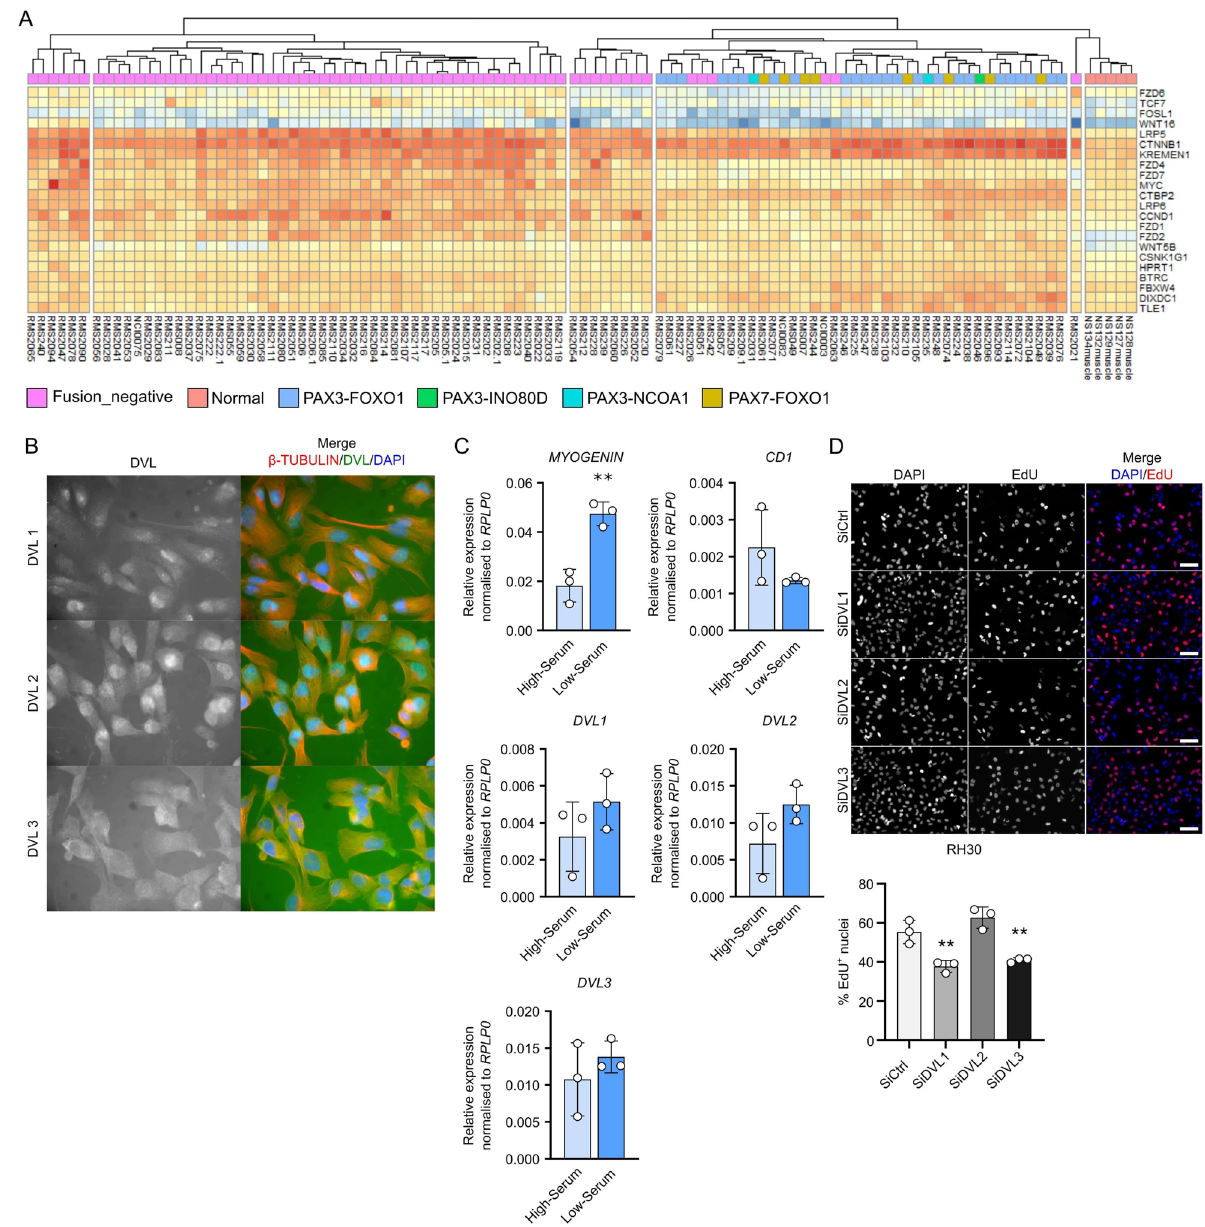
Figure 8. Knockdown of DVL1 or DVL3 reduces proliferation in alveolar rhabdomyosarcoma cells. ( A ) Heatmap of 22 differentially expressed genes associated with the WNT pathway in fusion-negative (pink) and fusion-positive (various colours) rhabdomyosarcoma biopsies and healthy muscle controls (Normal – orange) (GSE108022). ( B ) Localisation of DVL1-3 (green) in RH30 ARMS cells exposed to high-serum medium, co-immunolabelled for β-TUBULIN (red) with nuclei counterstained with DAPI (blue). ( C ) Gene expression profiles for DVL1-3 , the proliferation marker CD1 and the early differentiation marker MYOGENIN in RH30 cells exposed to high or low-serum medium. N = 3 independent biological replicates. Significant differences were assessed using a students unpaired two tailed T-test, comparing high-serum to low-serum culture conditions where two asterisks denote p < 0.01. (D) Representative images of proliferating RH30 cells that have incorporated EdU (red) after individual knockdown of each DVL isoform for 48 h, with nuclei counterstained with DAPI (blue). Scale bar represents 100 µm. Quantification of EdU containing cells as a percentage of total nuclei after knockdown of each DVL isoform. Statistically significant differences were calculated using a One-Way ANOVA with Dunett’s post-hoc test, comparing each group with the control (SiCtrl). A significant difference is denoted via two asterisks where p < 0.01. More than 200 nuclei were analysed for each of N = 3 biological